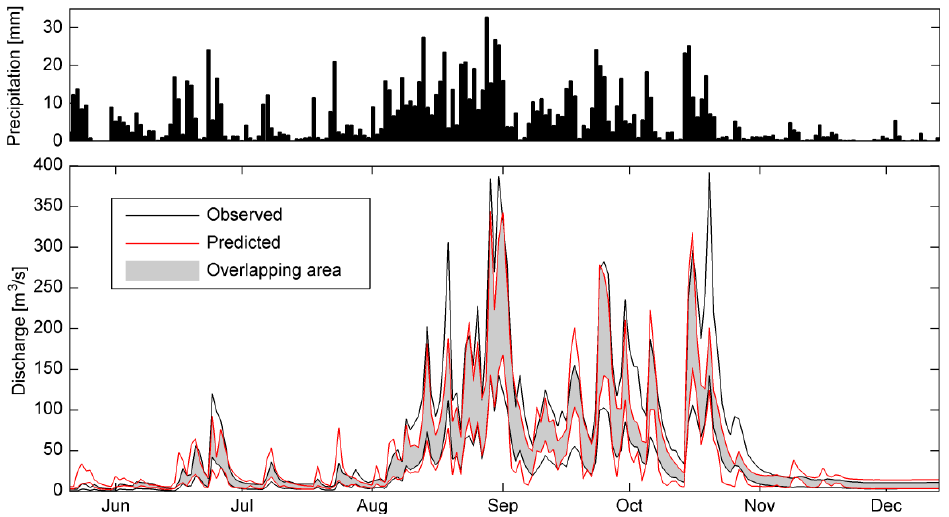
Fig. 12. Uncertainty limits for observed discharge and predicted discharge (5% and 95% percentiles of the predicted discharge of all Fig. 12 Uncertainty limits for observed discharge and predicted discharge (5% and 95% 1046 behavioural parameter-value sets) in the rainy season 1995 with WASMOD parameters calibrated 1980–1988 using the R FDC − V performance measure in the Paso La Ceiba catchment. The overlapping area between the two uncertain intervals is plotted in